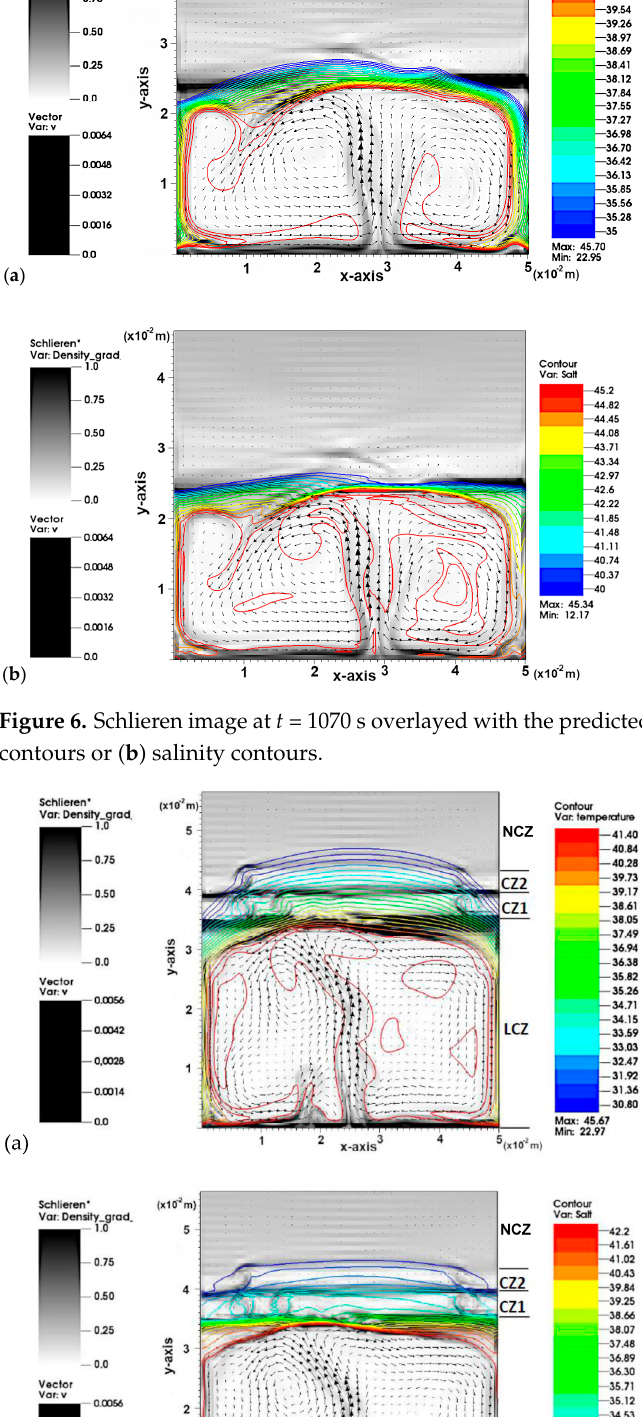
Figure 5. Schlieren image at t = 580 s overlayed with the predicted velocity field and ( a ) temperature contours or ( b ) salinity contours.